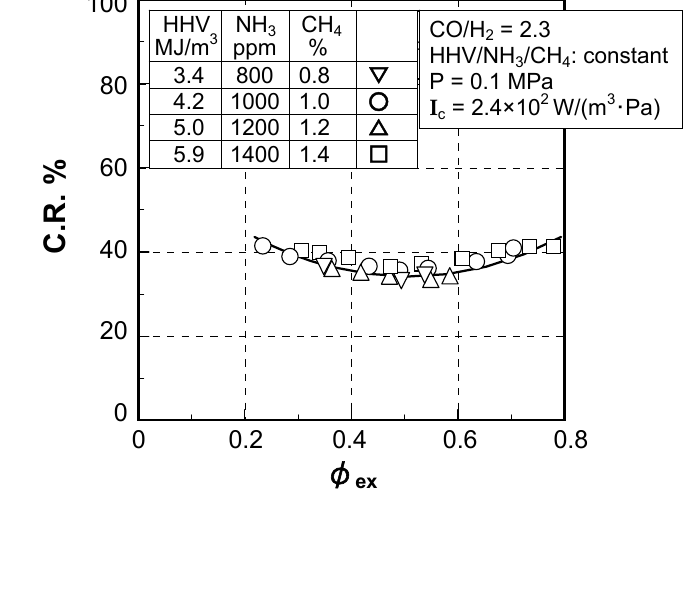
Figure 56. Influence of NH